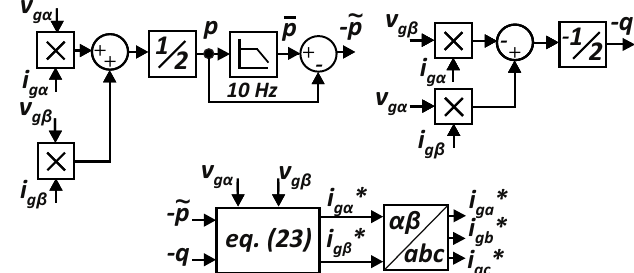
Figure 6. Harmonic filtering and reactive power compensation strategy.